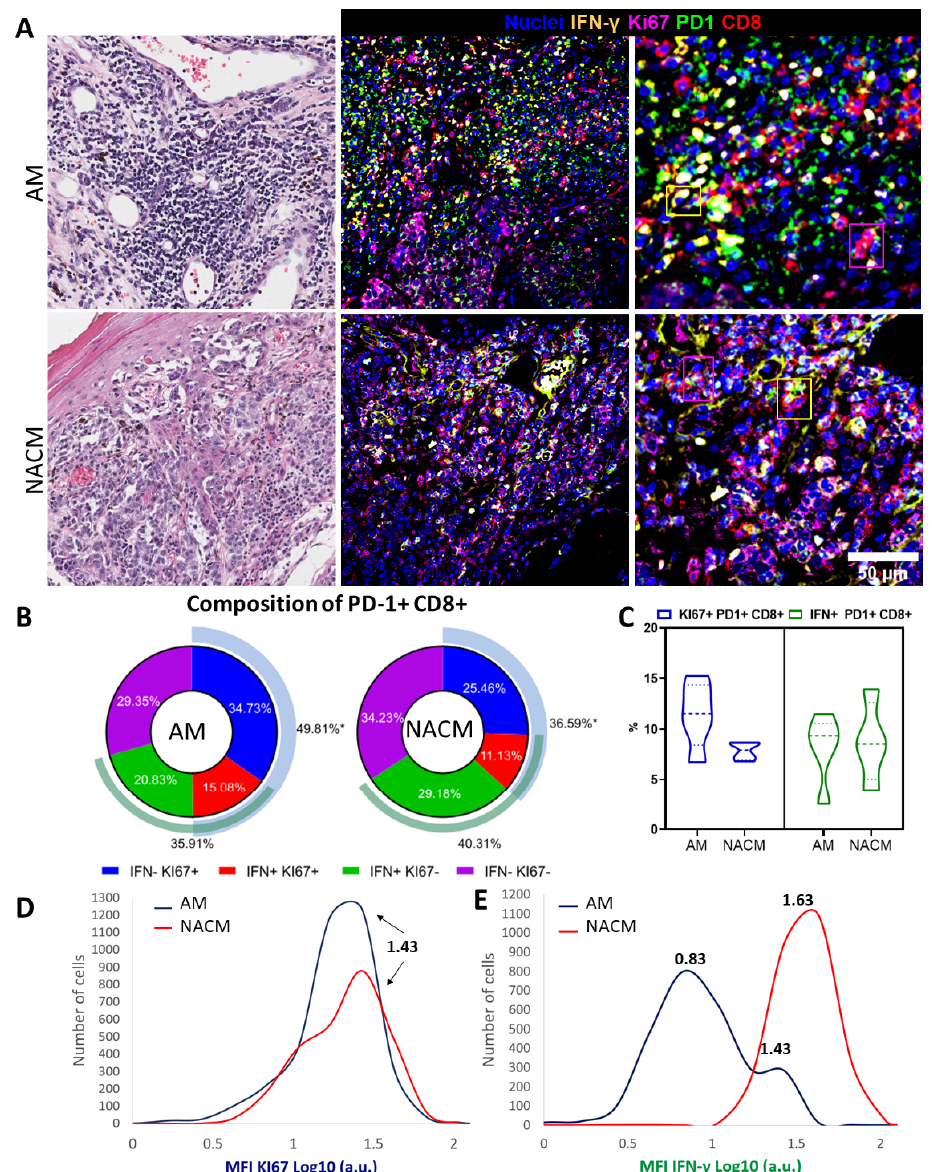
Figure 6. Melanoma infiltrating PD-1 + CD8 T cells express functional markers. ( A ) Representative hematoxylin & eosin (left) and immunofluorescence (IF) images (middle and right (zoomed of a highly infiltrated area) of advanced acral melanoma (AM) and advanced non-acral cutaneous melanoma (NACM). IF staining: CD8 (red), PD-1 (green), IFN- γ (yellow), KI-67 (magenta) and nuclei (blue). Yellow and magenta squares point out to IFN- γ + PD-1 + CD8 + T cell and KI-67 + PD-1 + CD8 + T cell, respectively. ( B ) Pie charts showing the proportion of PD-1 + CD8 + T cells expressing IFN- γ and/or KI-67. External elements represent the total IFN- γ fraction (green), and total KI-67 fraction (blue). ( C ) Violin plots showing comparisons of the percentages of KI-67 + PD-1 + CD8 T cells (blue) and of IFN- γ + PD-1 + CD8 T cells (green) in AM and NACM. ( D , E ) Normalized mean fluorescence intensity (MFI) of KI-67 ( D ) and IFN- γ ( E ) expression in KI-67 + PD-1 + CD8 T cells or IFN- γ + PD-1 + CD8 T cells, respectively. Arbitrary fluorescence units Log10 Scale. We show in Supplementary Figure S7 a representative staining of every channel to better visualize each mark individually. In addition, we show in Supplementary Figure S8 the acquired images of the bleached tissue to illustrate that the first round of fluorescence staining was excluded from the analysis of the second round of staining. Statistical analysis: Student’s t -test, * p <